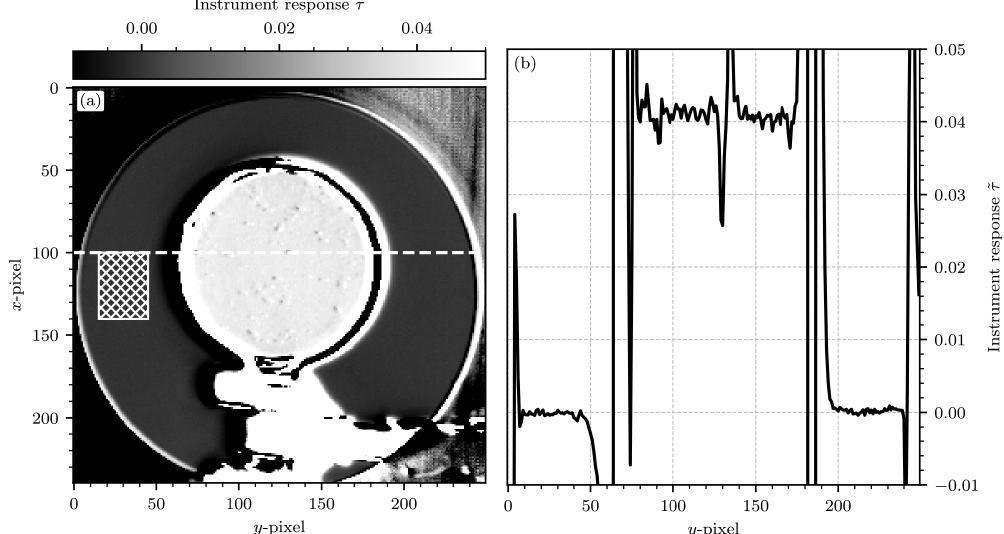
Figure 9. (a) The processed camera image for reference cell no. 4. The cell is in the center of the image. The circular structure behind it is the opening of the integrating sphere, in which a halogen lamp is placed as the light source of the experiment. The foreground shows the stand and clamp that are used to hold the cell in front of the integrating sphere. The in-cell region of the test cell shows a larger instrument signal than the background. The background region of our choice is marked with a patterned rectangle (left of the cell). (b) The instrument signal plotted along a vertical cross section through the middle of the test cell at x = 100 (see the dashed line in a ). The region in the middle shows the enhanced signal within the cell. The strong peaks separating the background region and the in-cell region are generated by the frame of the cell. The strong structure that can be seen in the middle of the cell at around y = 130 is due to condensation on the inside of the cell or similar imperfections of the experimental setup.